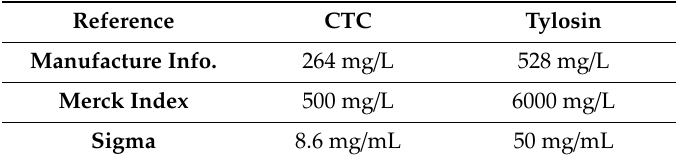
Table 1. Chlortetracycline (CTC) and tylosin water